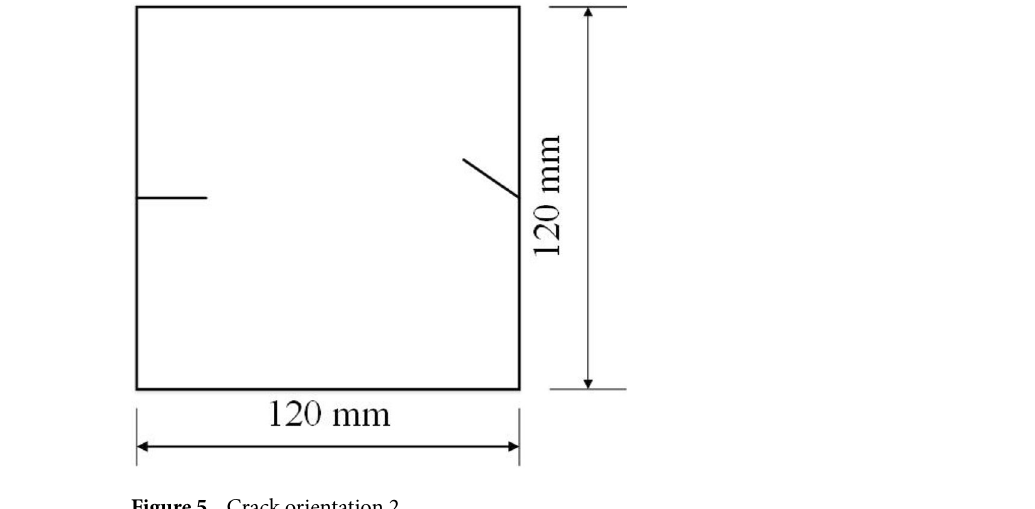
Figure 5. Crack orientation 2.